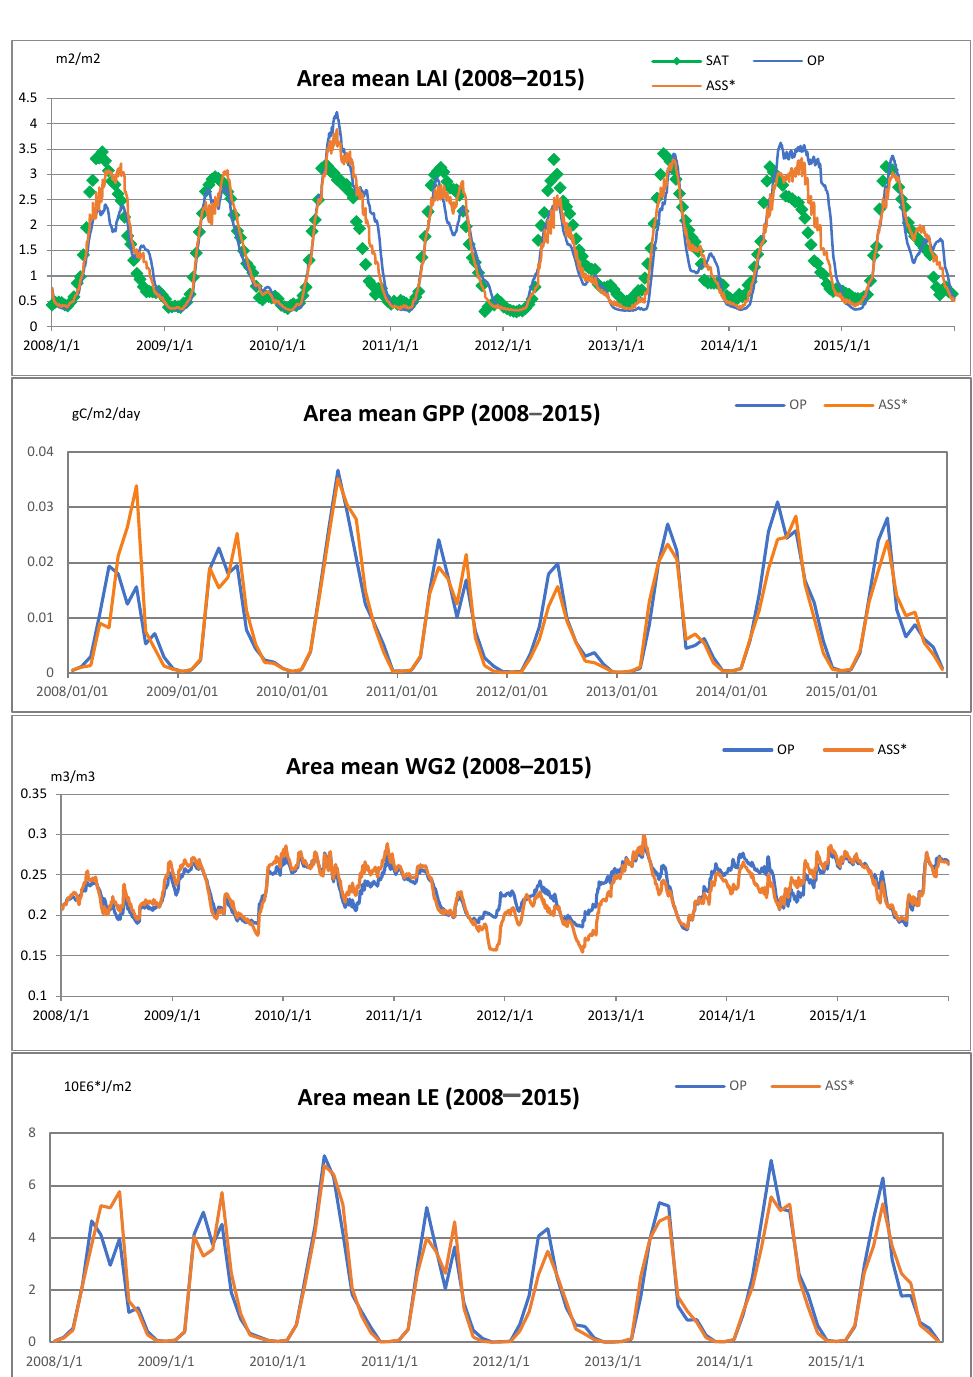
Figure 5. Time series of open-loop (blue), observed (green) and assimilation (orange) LAI (first row), GPP (second row), WG2 (third row), and LE (fourth row) averaged over Hungary from 2008 to 2015.